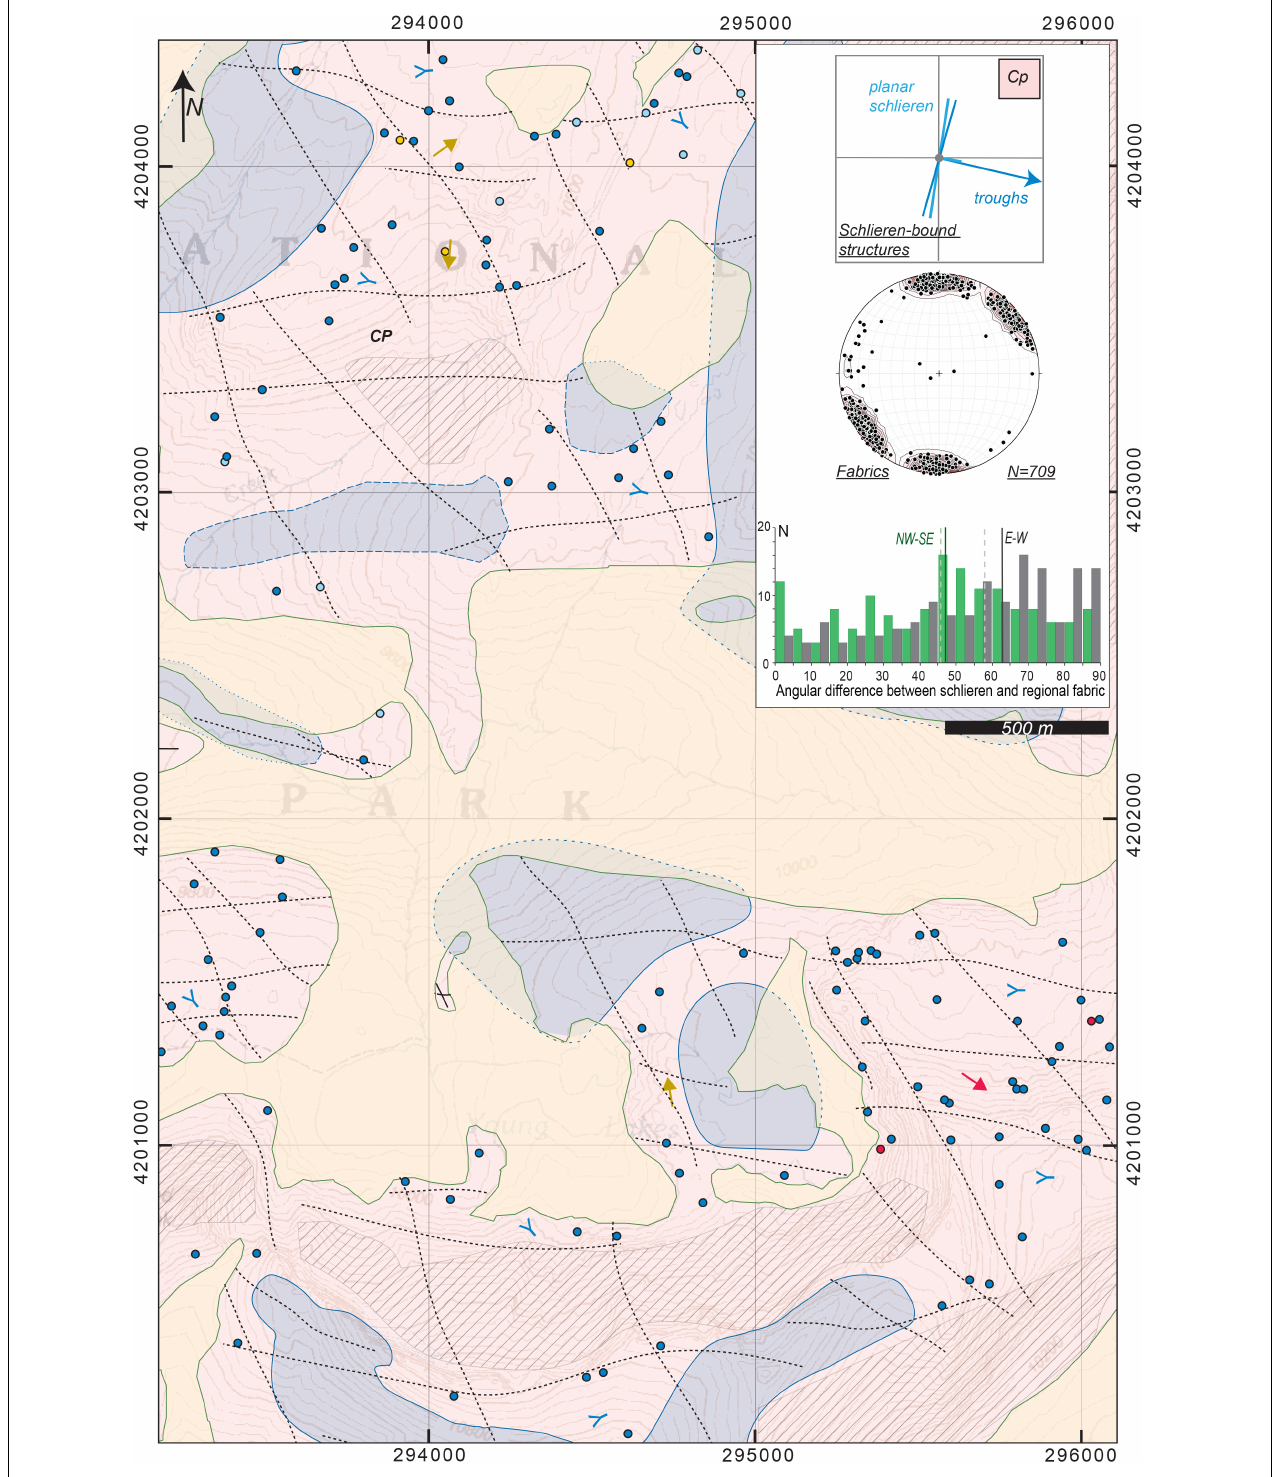
FIGURE 7 | Magmatic structures field data summary of the Young Lakes area, NE quadrant. Bold lines mark major unit contacts. Hatching indicates unmapped areas. The trend of steeply dipping (70 ◦ –90 ◦ ) magmatic foliations is shown by dashed lines. Magmatic lineations are steeply plunging, regardless of the strike of the foliation. The locations of different schlieren-bound structures are shown by colored dots (see key in Figure 6 ). Y or arrow symbols are oriented in the direction of measured migration/younging. Inset box shows the domain-scale magmatic foliation summary on a stereonet, and a summary of average younging/migration orientations shown with arrows. For Glen Aulin and Young Lakes domains, angular difference measurements between the foliations and schlieren are shown as a histogram in the inset box, color-coded by fabric type. CP-Cathedral Peak granodiorite. Co-ordinate system used: UTM NAD27 zone 11S.